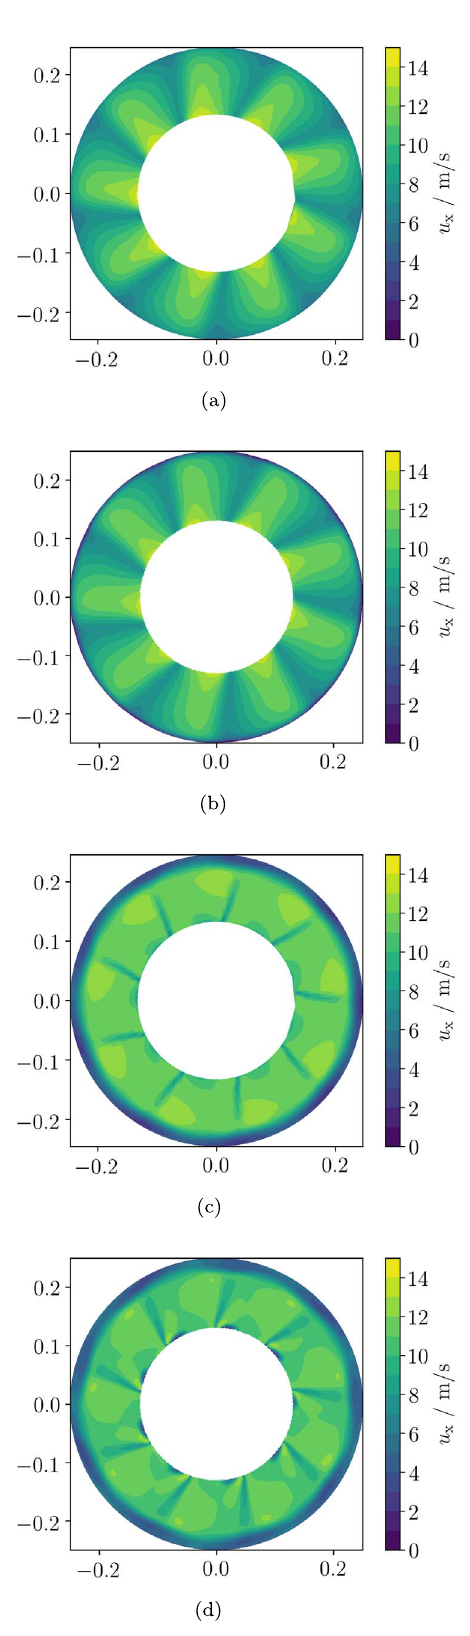
Figure 17. Mean fl ow velocity in axial direction. (a) Suction side measured. (b) Suction side simulated. (c) Pressure side measured. (d) Pressure side